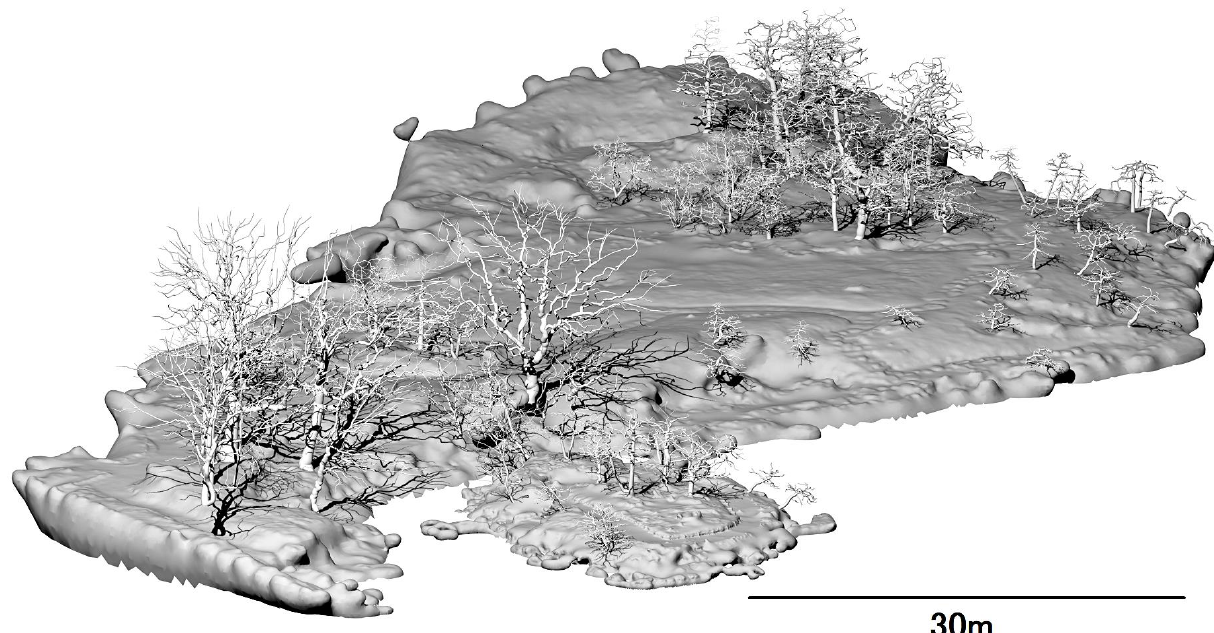
Figure 9. Constructed 3D tree model of the target area